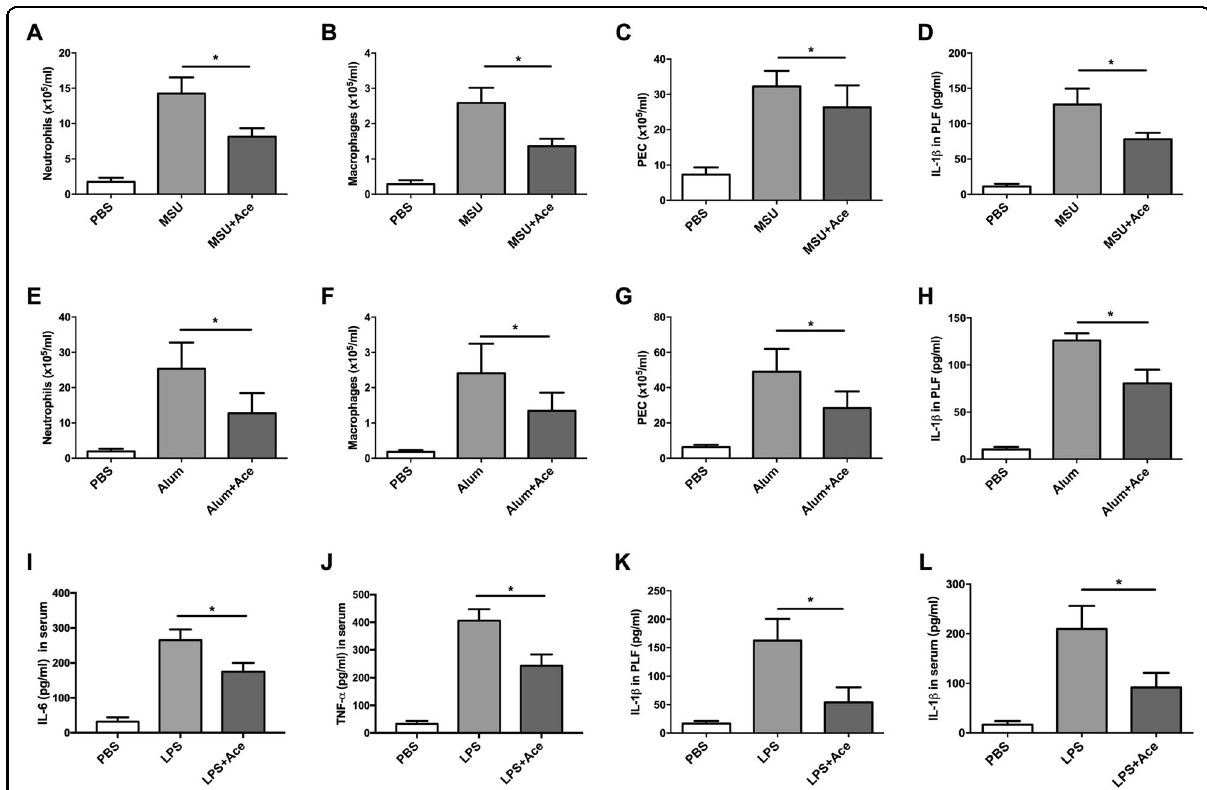
Fig. 3 Acetate suppresses in fl ammasome-mediated peritoneal in fl ammation in vivo. a – h Acetate (20 mM) suppressed MSU- ( a – d ) and alum- ( e – g )-induced peritoneal in fl ammation. Flow cytometry revealed that neutrophils (CD11b + GR-1 + ) ( a , e ), macrophages (F4/80 + ) ( b , f ), peritoneal exudate cells (PECs) ( c , g) and IL-1 β (ELISA) in the peritoneal lavage fl uid (PLF) ( d , h ) were decreased in the acetate pretreatment group; i – l acetate suppressed LPS-induced peritonitis ( n = 3). Serum levels of IL-6 ( i ), TNF- α ( j ), IL-1 β ( l ), and IL-1 β in PLF ( k ), as measured by ELISA, decreased in the acetate treatment group ( n = 3); * P < 0.05, Student ’ s t- test compared with the model group (MSU, Alum or LPS). n = biological replicates. Data